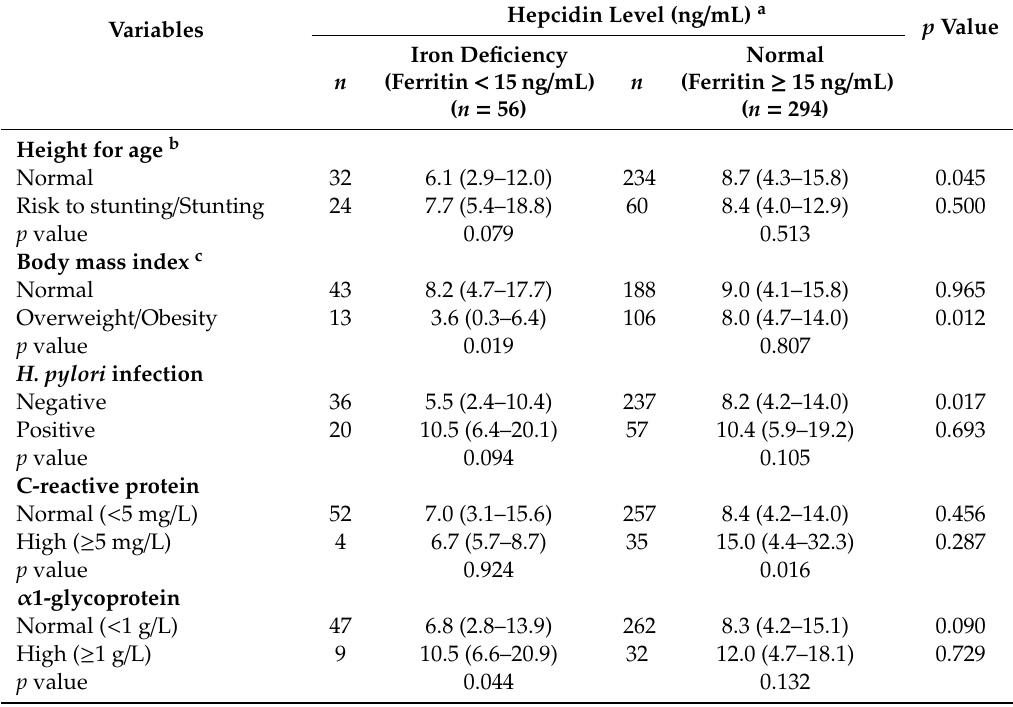
Table 2. Serum hepcidina levels in children by iron nutritional